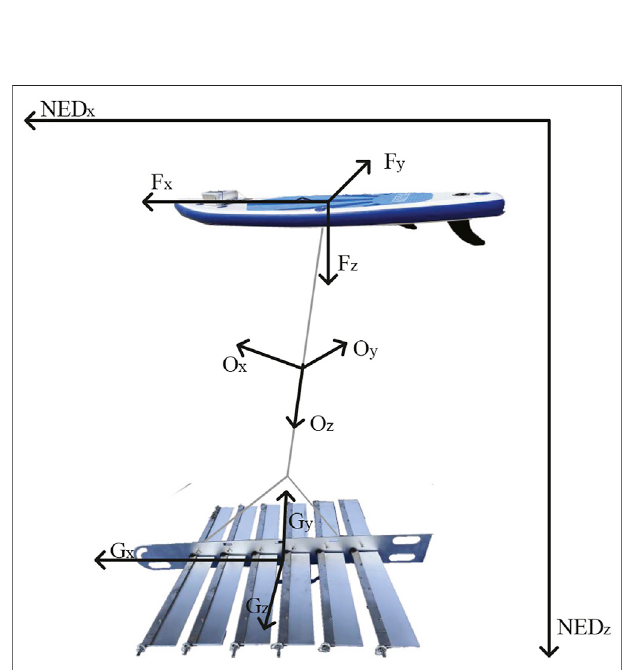
- Pitch angle θ : The angle between z-axis and vertical plane. θ